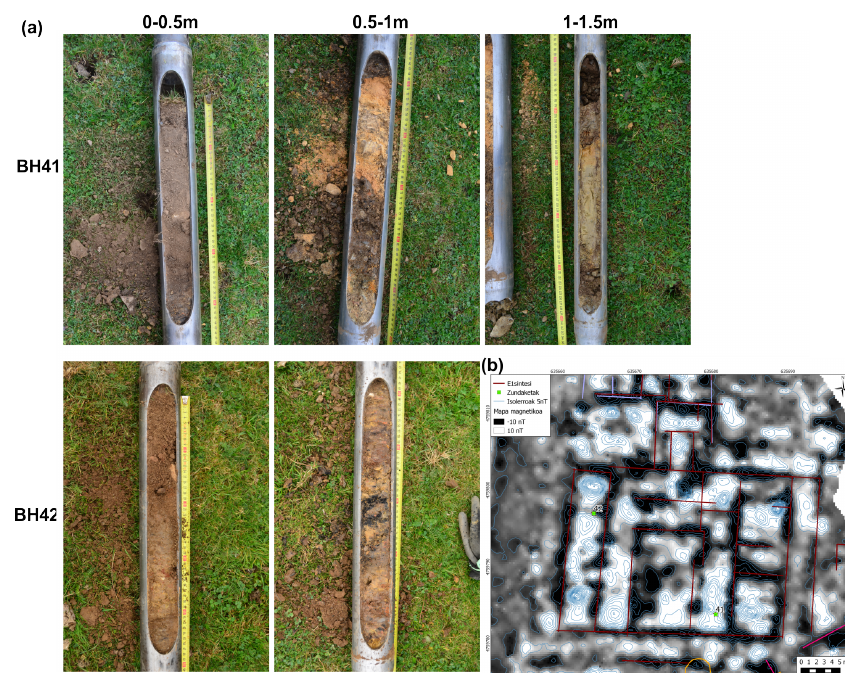
Figure 8. ( a ) Pictures of the sediment cores extracted on locations BH41 and BH42. ( b ) Magnetic results of the area ( ± 10 nT) where the location of the cores can be seen. The area is highlighted in the general context of Figure